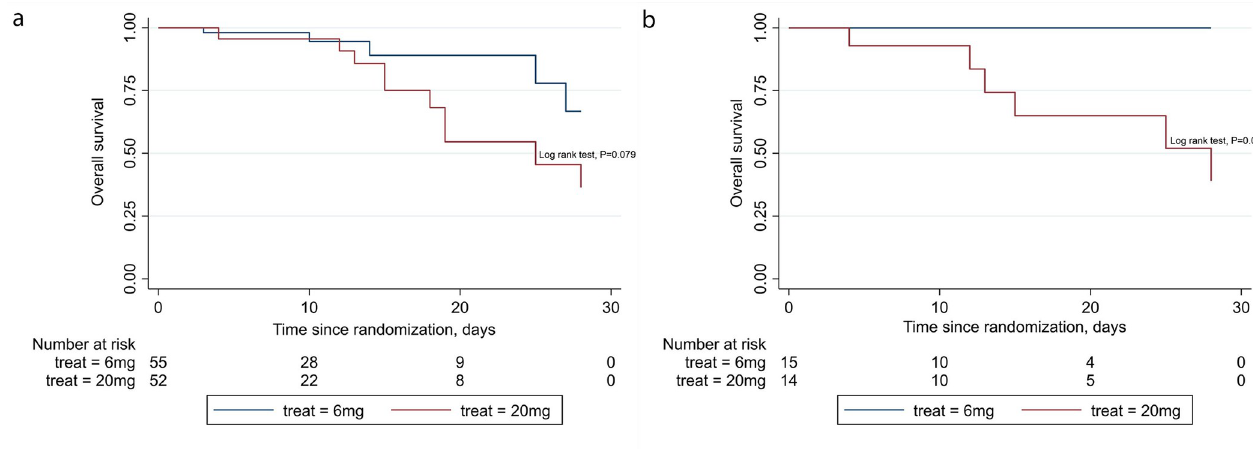
Fig 2. Kaplan-Meier survival curves a. in high-dose and low-dose groups and b. for subgroups with OSCI = 5 at randomization.